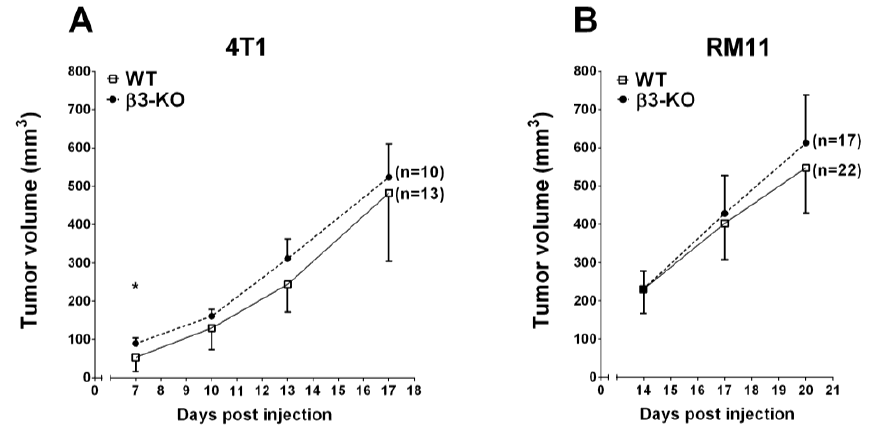
Figure 1. The growth of 4T1 ( A ) and RM11 ( B ) tumors in WT and β3-KO mice measured every other third day. A total of 3 × 10 5 4T1 and 2 × 10 5 RM11 cells were injected into the fat pad and subcutaneously on the mouse flank, respectively. Mean ± SEM. * p < 0.05.